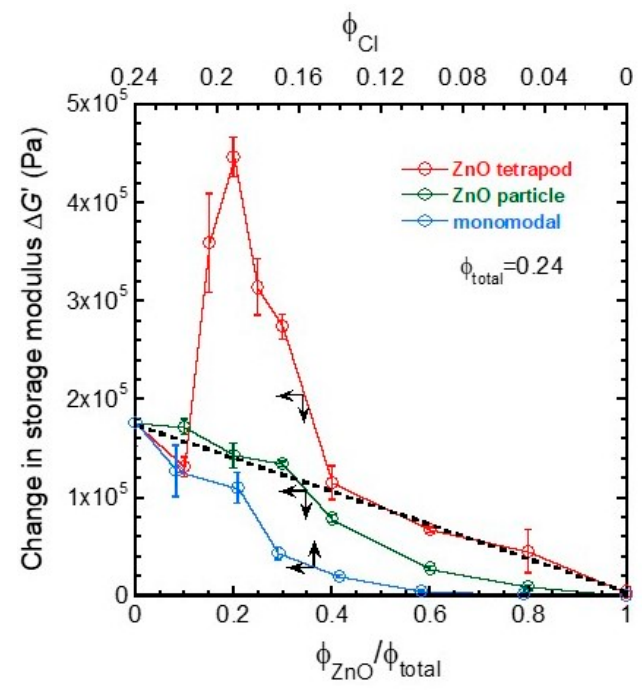
Figure 5. Change in storage modulus for bimodal magnetic elastomers containing nonmagnetic particles or tetrapods as a function of the substitution ratio. The change in storage modulus for monomodal magnetic elastomers with the same volume fraction of magnetic particles as bimodal magnetic elastomers, is also shown (Frequency 1 Hz, Strain 10 − 4 ).